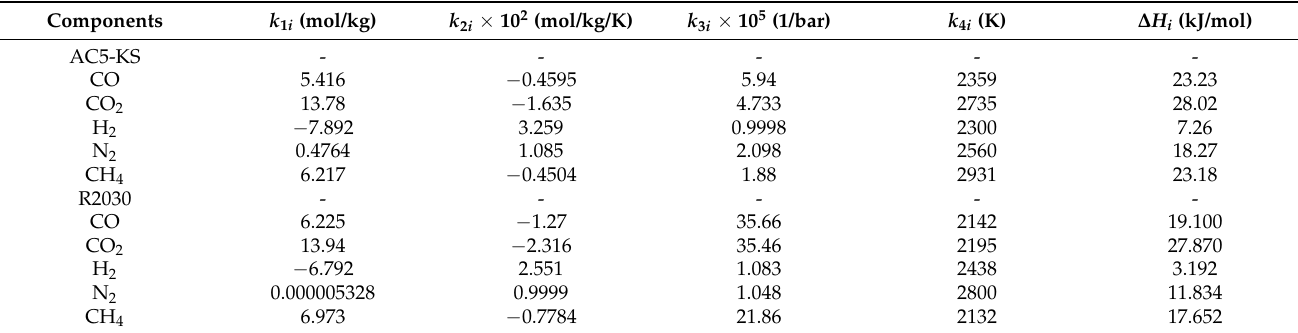
Table 1. Adsorption isotherm parameters and isosteric heats of adsorption for AC5-KS and R2030 [30].